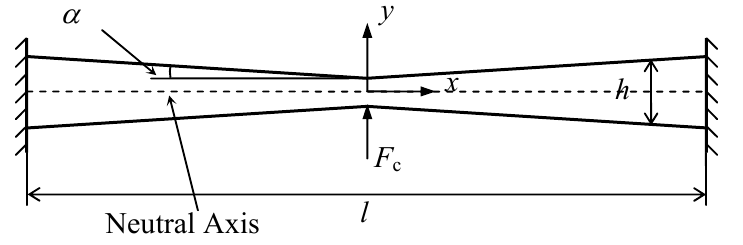
Figure 5. Schematic diagram of the sense